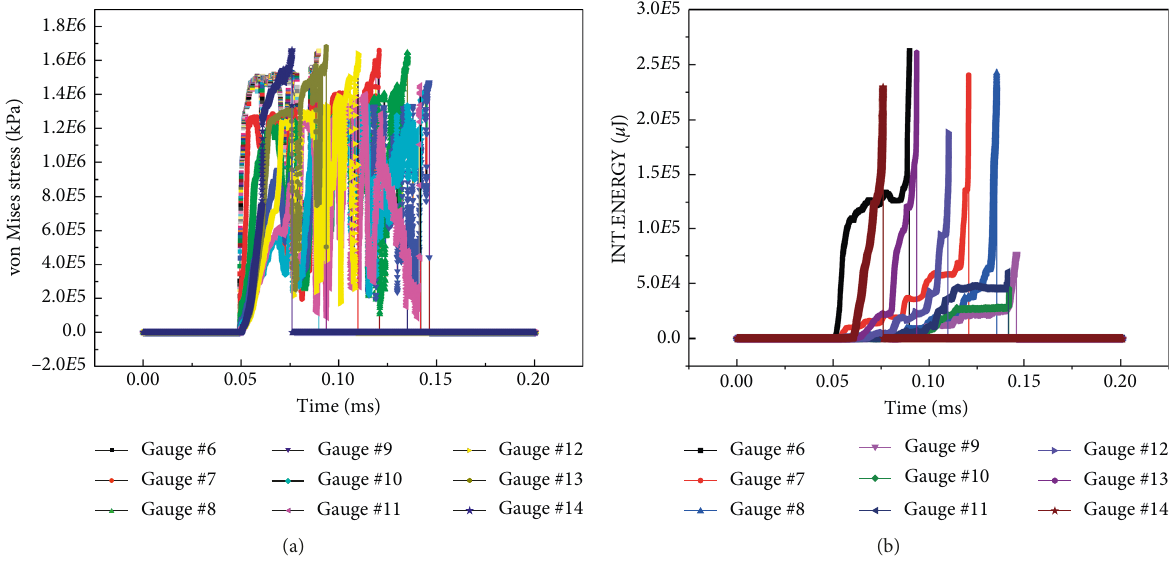
Figure 8: Stress, energy, and damage histories on impair slot. (a) von Mises stress and (b)